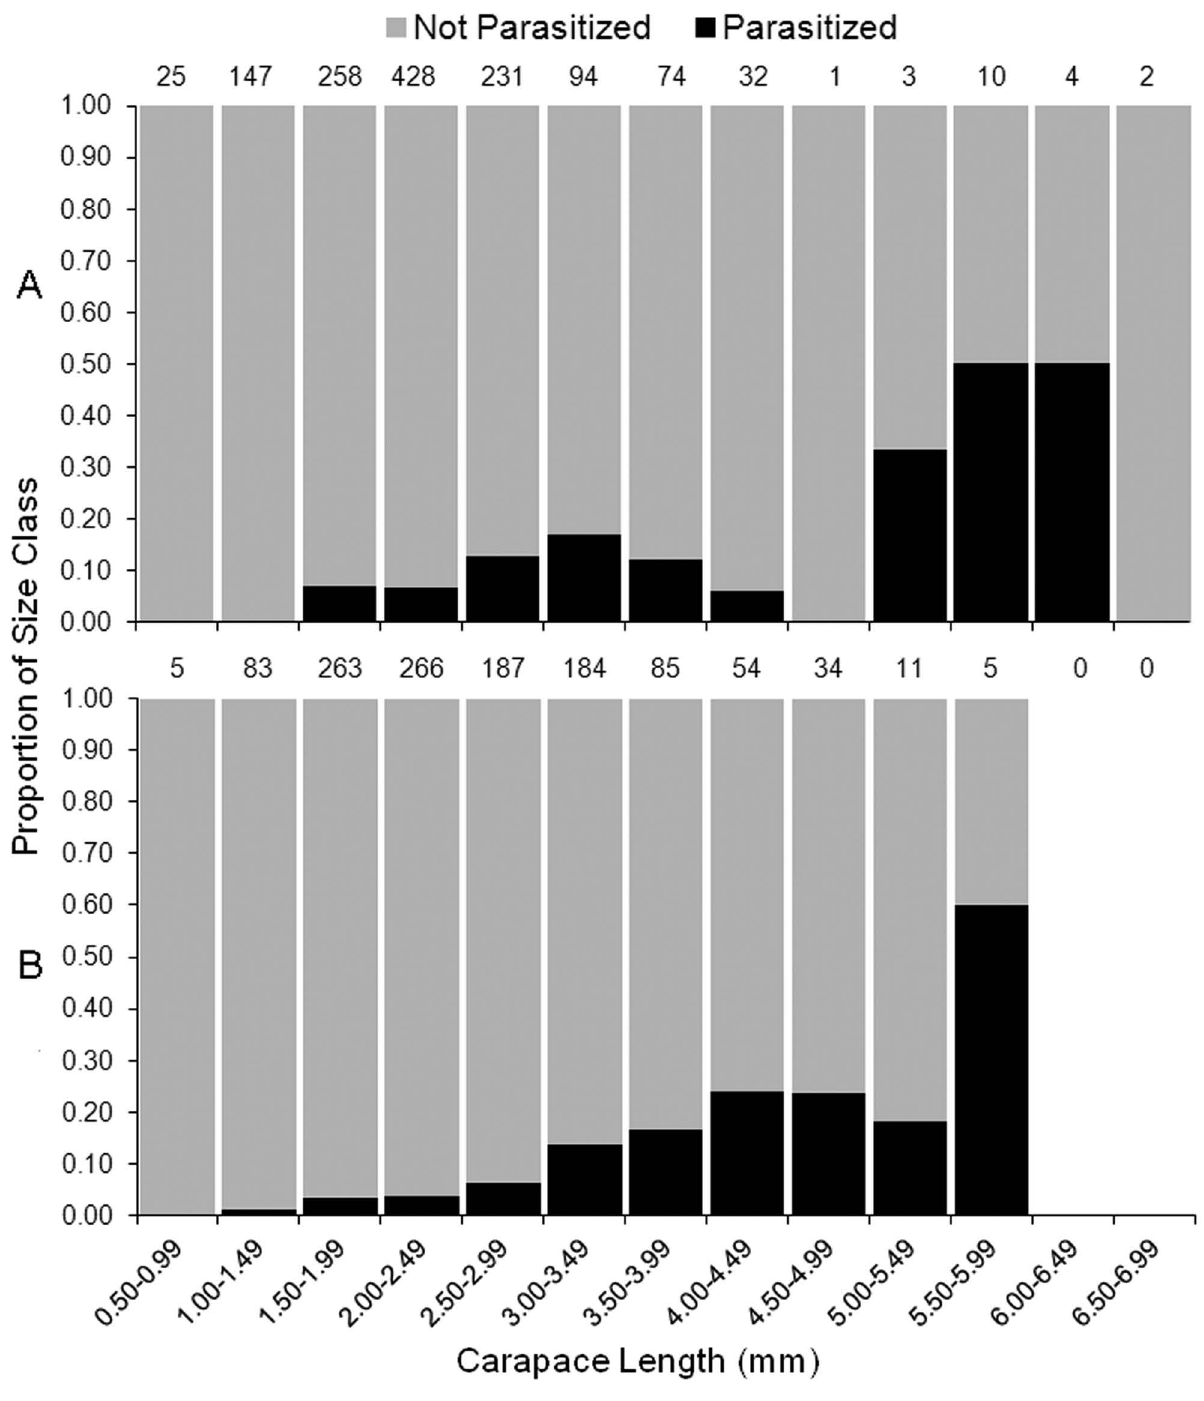
Figure 3. Urobopyrus processae . Proportion of each size class of shrimp Ambidexter symmetricus parasitized by U. processae in (A) 2010 and (B) 2011 (numbers above bars correspond to total number of individuals collected in that size